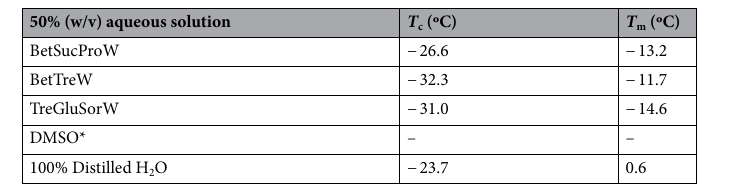
Table 2. Melting temperatures for the aqueous mixtures of BetSucProW, BetTreW, TreGluSorW, DMSO and distilled water. All these values refer to the ones obtained at onset temperature. *For DMSO 50% v/v solutions were